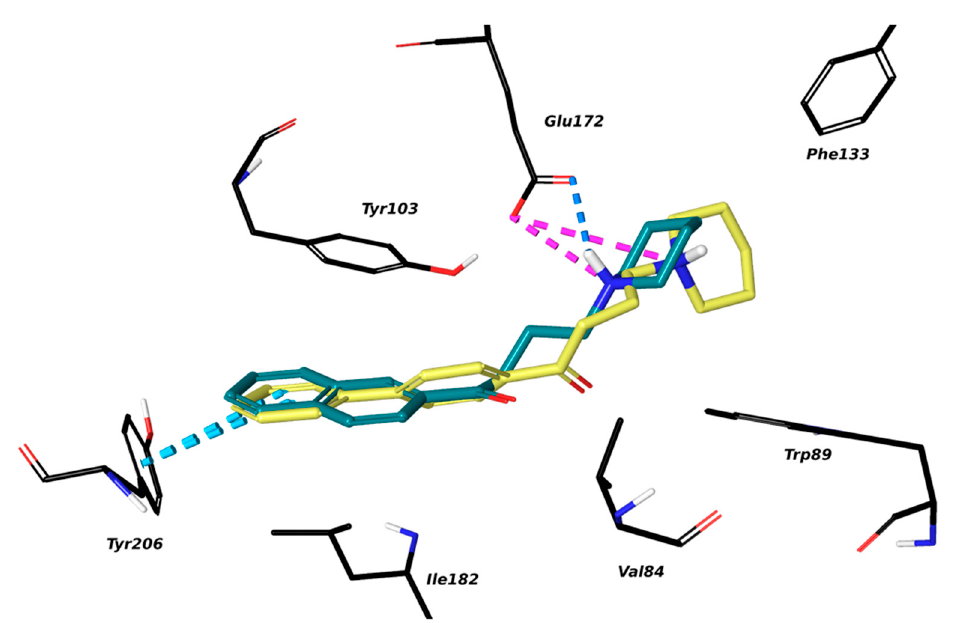
Figure 6. Binding mode of 11 (in turquoise sticks) and 12 (in yellow sticks). The main amino acids of the protein involved in the binding are represented as black wires. Dashed lines indicate the π stackings (in cerulean), the electrostatic interactions (in pink), and H-bonds (in blue). Atoms are colored-coded (oxygen in red, nitrogen in blue).